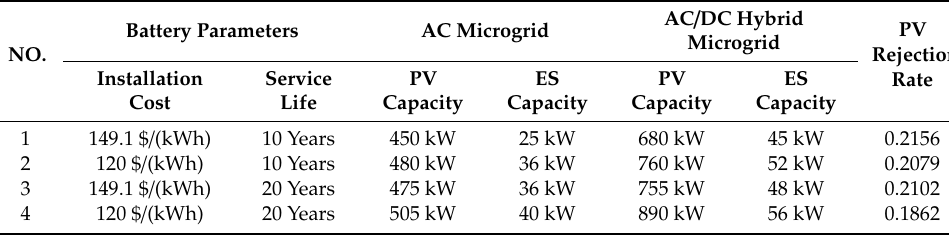
Table 4. E ff ect of energy storage factor on optimal configuration Table 4. Effect of energy storage factor on optimal configuration results.